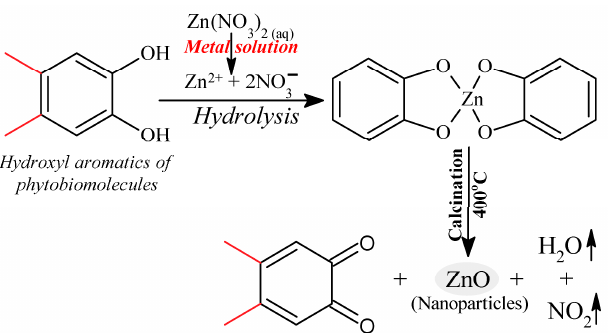
Figure 3. Mechanism of formation of O. vulgare -mediated ZnO NPs. Adapted from [124].